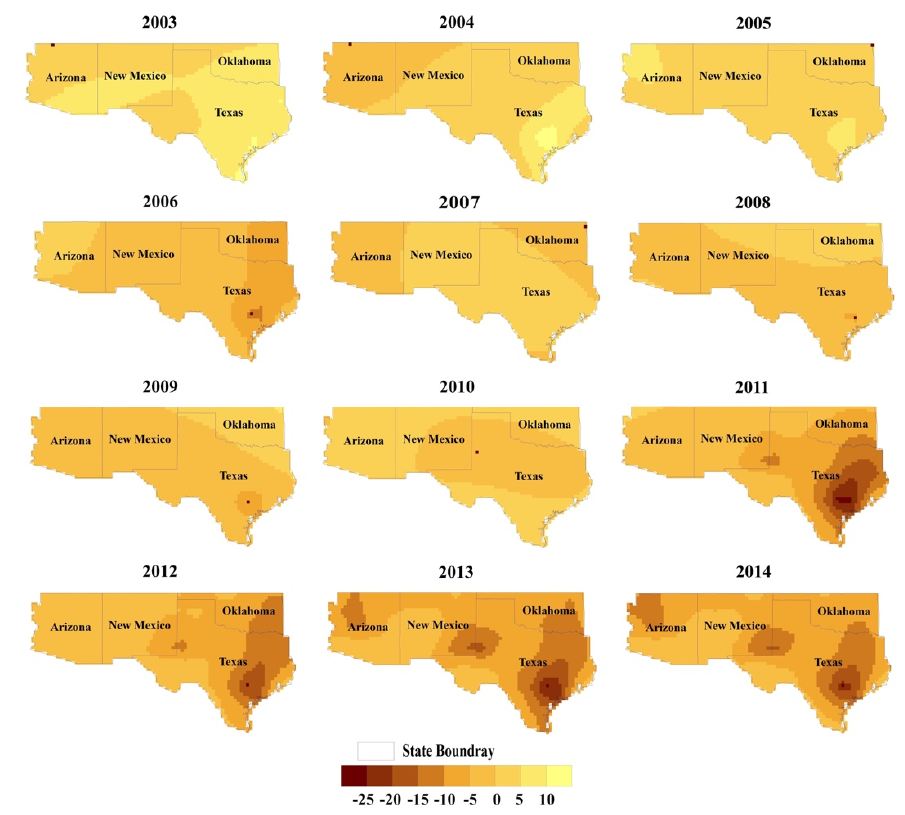
Figure 1. Annual average for water storage across the Southwest United States (SWUS) from 2003 to 2014.